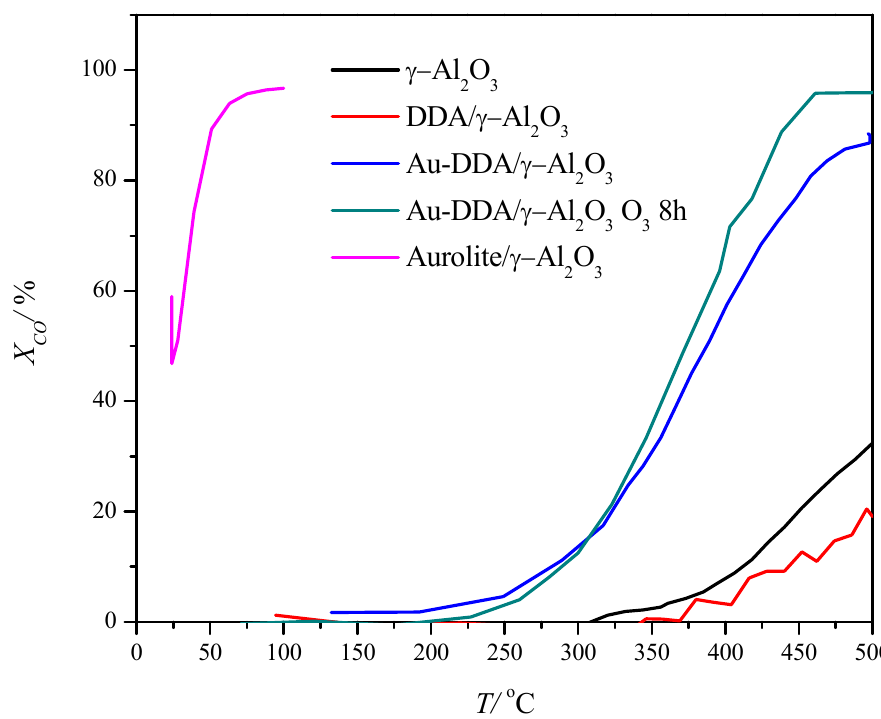
Figure 6. CO conversion versus temperature for γ‐ Al 2 O 3 ; DDA/ γ‐ Al 2 O 3 ; Au ‐ DDA/ γ‐ Al 2 O 3 ; Au ‐ DDA/ γ‐ Al 2 O 3 (O 3 8 h); and AUROlite TM .